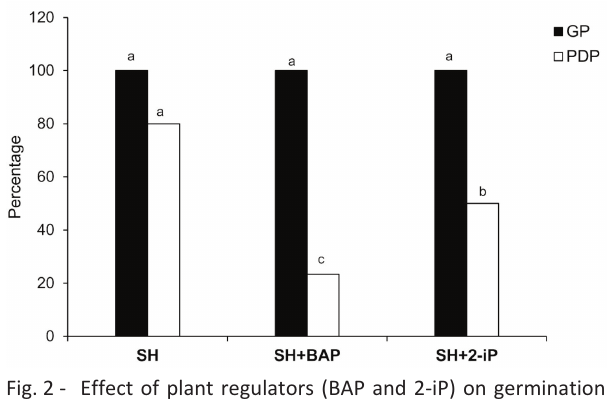
Fig. 2 ­ Effect of plant regulators (BAP and 2­iP) on germination (GP) and plant development (PDP) percentages of Cycas revoluta zygotic embryos cultured on SH medium. ZEs were cultured on SH medium solidified with gelrite and supplemented with 0.5 mg/l of BAP or 0.5 mg/l of 2iP. Bars with different letters indicate the statistical signifi­ cance (p<0.05) according to LSD test.